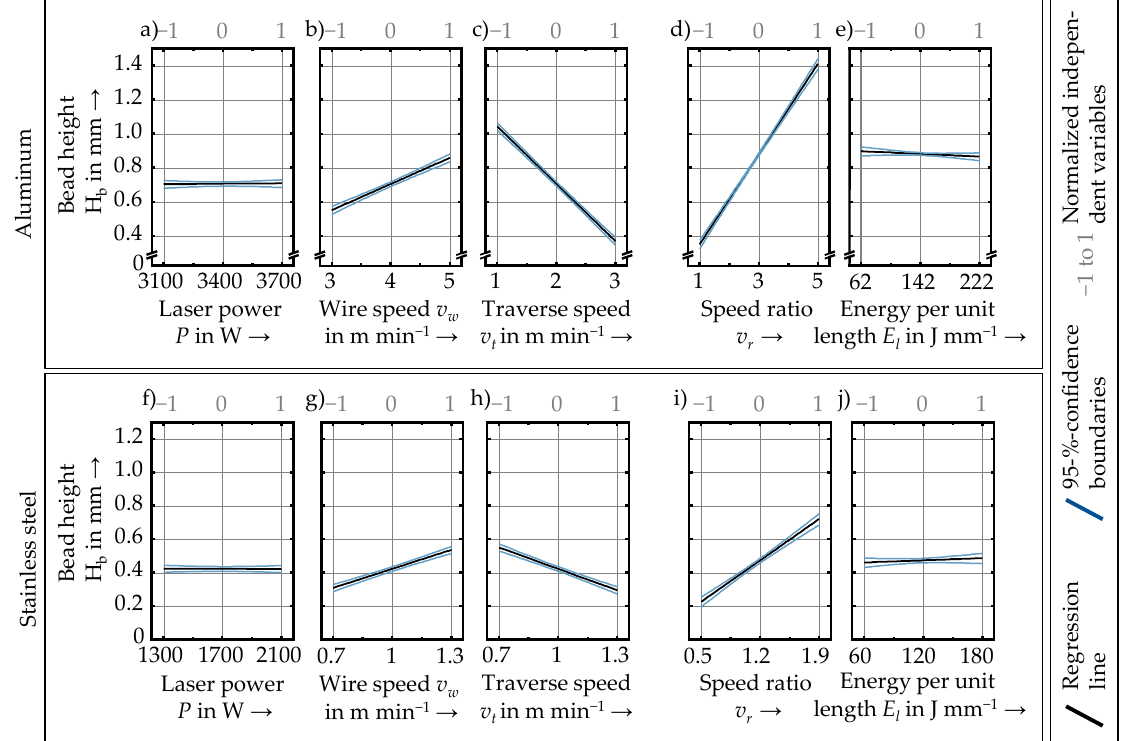
Figure 8. Main effects of the process parameters on the bead height of aluminum (upper row) and stainless steel (bottom row) samples; the single linear models used the independent variables power, wire speed, and traverse speed ( a – c ) and ( f – h ), as well as the independent variables speed ratio and energy per unit length ( d , e ) and ( i , j ).